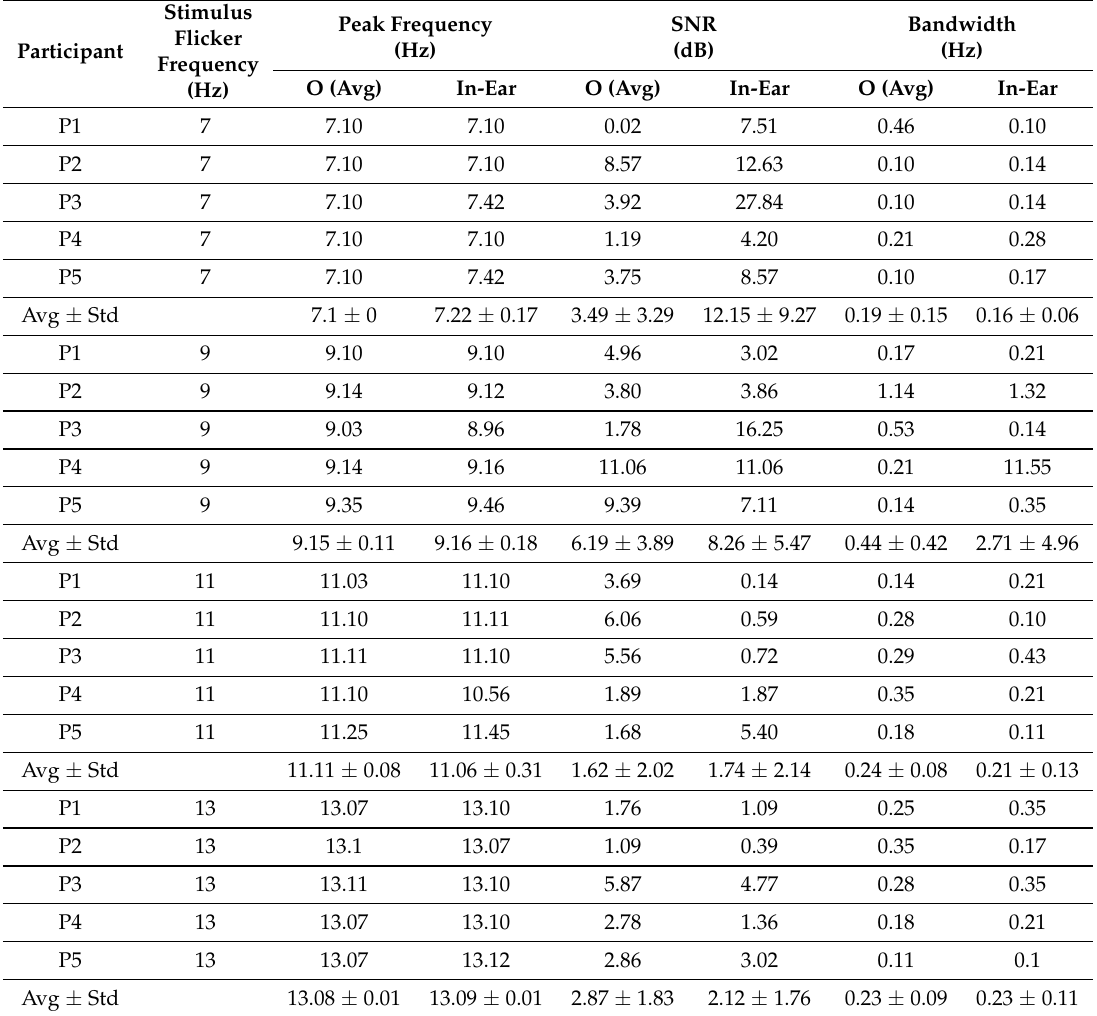
Table 1. Peak frequency, SNR and bandwidth of elicited SSVEP